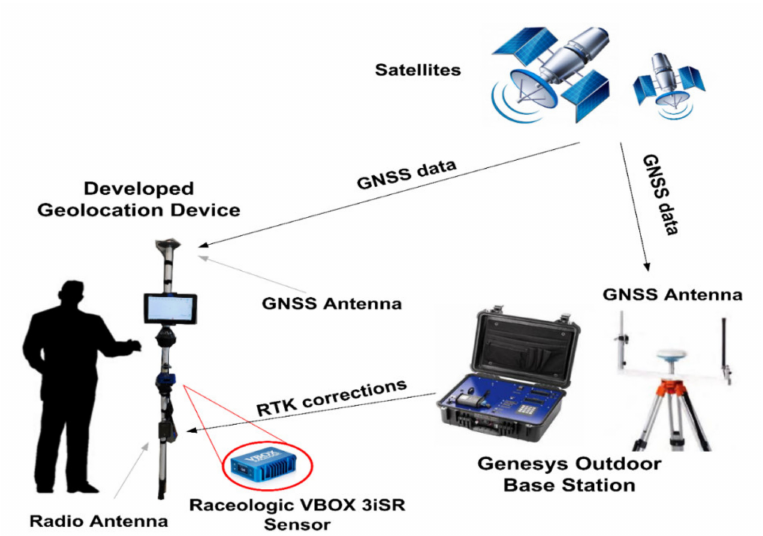
Figure 2. Configuration of the designed geolocation stake-out system to place a set of points on a track to carry out vehicle tests.